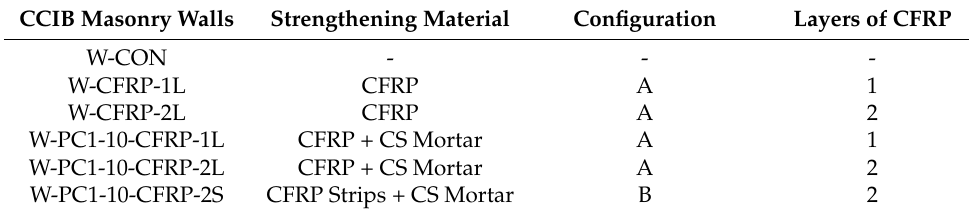
Table 1. Details of CFRP strengthening scheme.